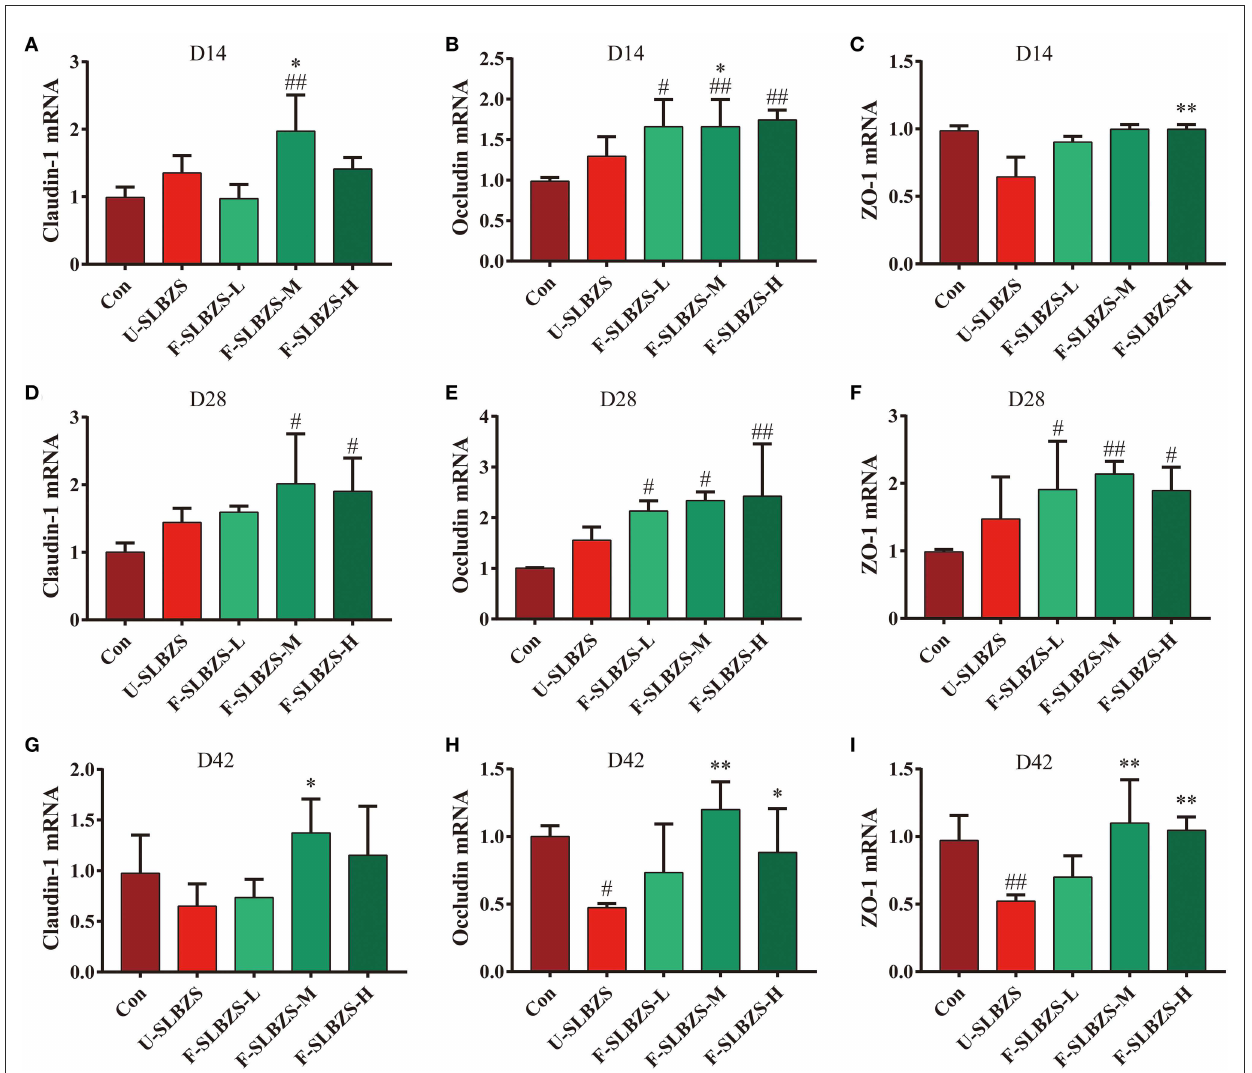
FIGURE6 Effects of fermented SLBZS on ileum intestinal barrier in broilers. (A) Relative mRNA expression of Claudin-1 in broiler cecum on day 14. (B) Relative mRNA expression of Occludin in broiler cecum on day 14. (C) Relative mRNA expression of ZO-1 in broiler cecum on day 14. (D) Relative mRNA expression of Claudin-1 in broiler cecum on day 28. (E) Relative mRNA expression of Occludin in broiler cecum on day 28. (F) Relative mRNA expression of ZO-1 in broiler cecum on day 28. (G) Relative mRNA expression of Claudin-1 in broiler cecum on day 42. (H) Relative mRNA expression of Occludin in broiler cecum on day 42. (I) Relative mRNA expression of ZO-1 in broiler cecum on day 42. Bars represent mean values ± SD ( n = 3). # and ## indicate p < 0.05 and p < 0.01 compared with the Con group, * and ** indicate p < 0.05 and p < 0.01 compared with the U-SLBZS